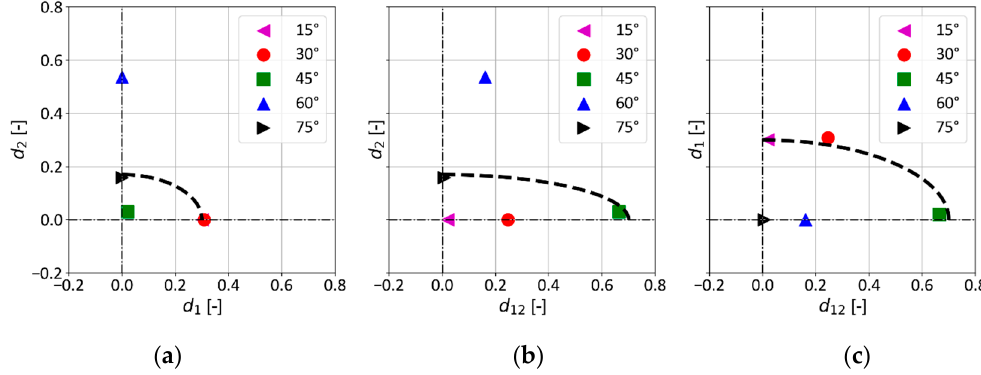
Figure 13. Two-dimensional representation of a 3D Tsai-Wu failure envelope for C / C–SiC with ( a ) d 1 – d 2 axis, ( b ) d 12 – d 2 axis and ( c ) d 12 – d 1 axis with experimental results (markers) for di ff erent fiber orientations.